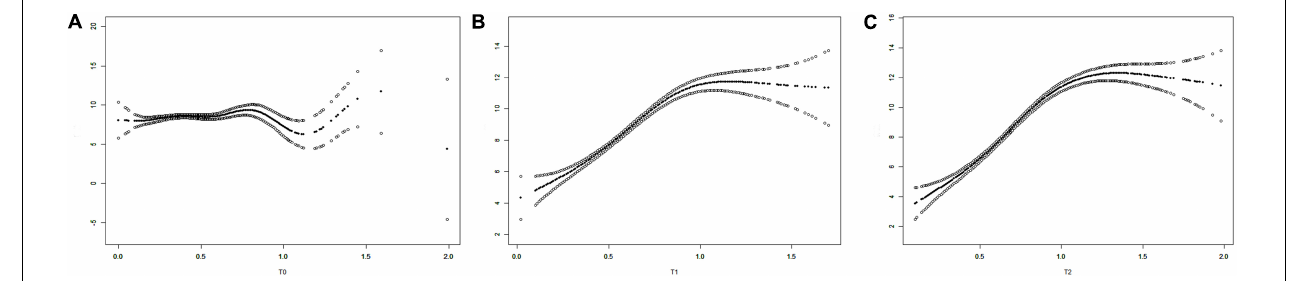
FIGURE 3 | The fitting curves showing the relationship of the T levels and the numbers of oocytes retrieved [ (A) T0, (B) T1, and (C) T2). T0: T levels at baseline, T1: T levels on the trigger day, and T2: T levels on the day after the trigger day.